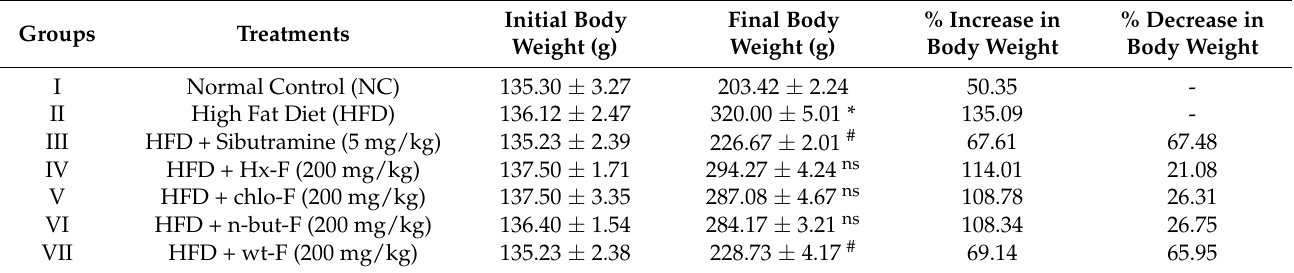
Table 5. Effects of Wt-F of B. diffusa extract on body weight in SD rats after 60 days of treatment. Groups